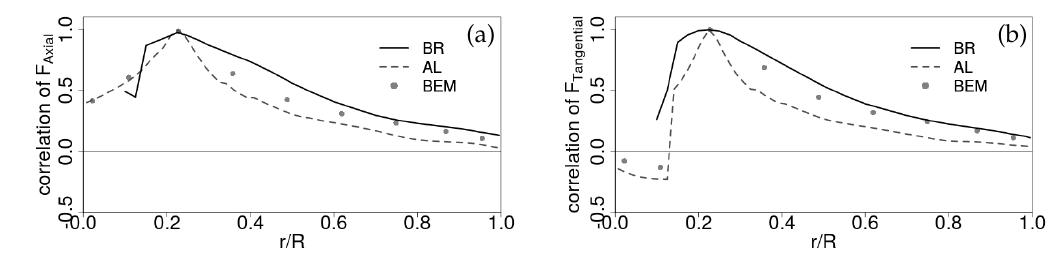
Figure 9. Correlation of ( a ) axial and ( b ) tangential forces at different radial positions with 22.5% position.